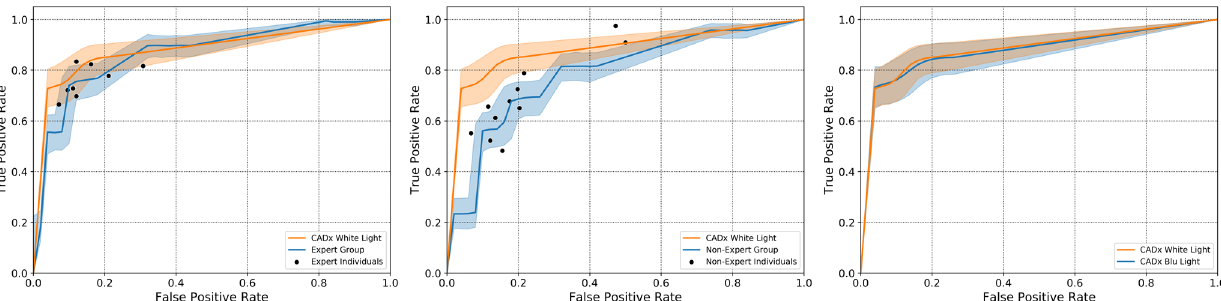
Fig. 2 ROC curves calculated using the bootstrap method. From left to right: CADx white light vs non-expert endoscopists, CADx white light vs expert endoscopists, and CADx white light vs CADx blue light. The light band around the ROC curves represents 95% con fi dence intervals derived by bootstrapping. Black dots represent individual reviewers' performances.